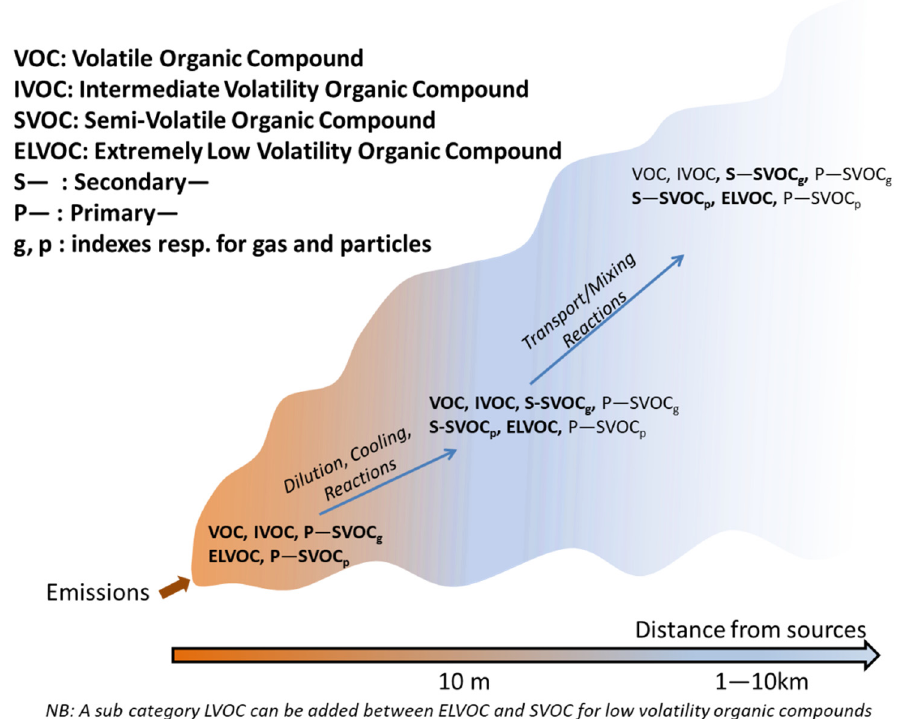
Figure 8. Schematic description of emission ageing in the atmosphere from a source.